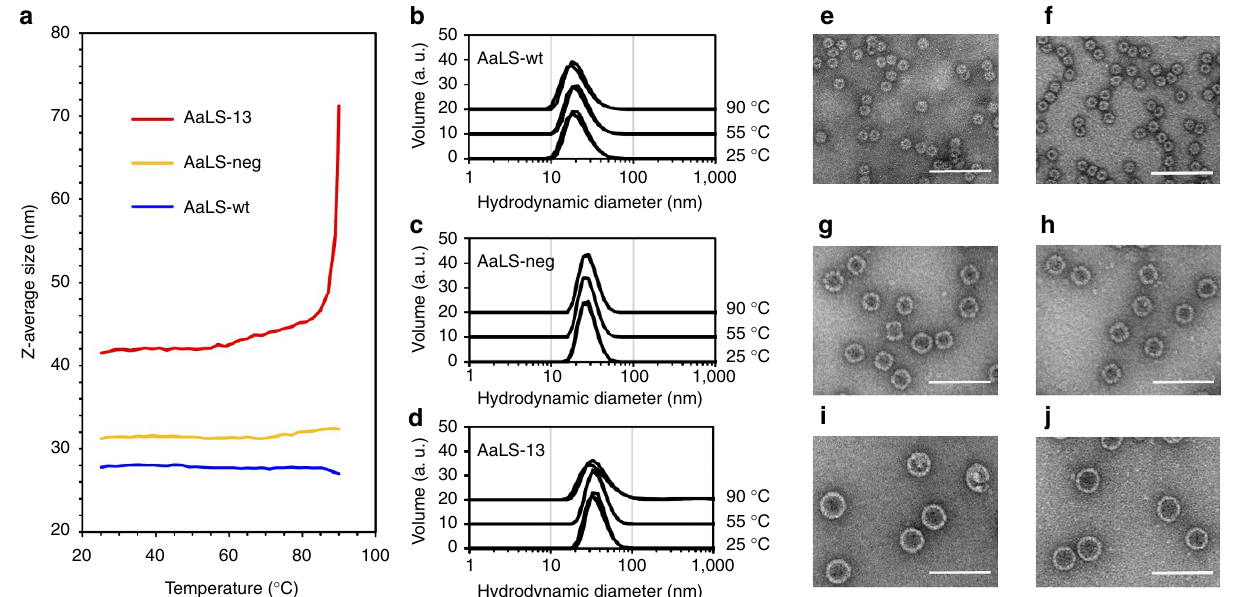
Figure 5 | Thermal stability of the AaLS variants. ( a ) DLS measurements with AaLS-wt (blue), AaLS-neg (ochre) and AaLS-13 (red). Z-Averages 68 of the particles are plotted against the measured temperature (25–90 (cid:2) C). The Z-averages of AaLS-neg ( B 32nm) and AaLS-13 ( B 42nm) correspond to the expected hydrodynamic diameters expected for 29- and 39-nm wide cages, respectively. However, the Z-average ( B 28nm) for AaLS-wt was significantly larger than the expected hydrodynamic diameter of a 16-nm wide cage, suggesting that a fraction of the particles aggregate in solution. ( b – d ) Volume weighted distribution of the hydrodynamic diameters determined for AaLS-wt ( b ), AaLS-neg ( c ) and AaLS-13 ( d ) at 25, 55 and 90 (cid:2) C. The individual histograms are offset by 10 arbitrary volume units (a.u.) for clarity. Three independent measurements were performed and plotted for each condition. ( e – j ) Negative-stain EM images of AaLS-wt ( e , f ), AaLS-neg ( g , h ) and AaLS-wt ( i , j ). Each sample was deposited on the EM grid without heating ( e , g , i ) or immediately after heating for 5min at 90 (cid:2) C ( f , h , j ). Scale bars, alignments of selected particles in 50 classes for AaLS-wt and AaLS-13 and 80 difference density and the resolution of the EM map does not allow modelling of a classes for AaLS-neg were performed by RELION 1.4. Particles that did not yield ligand at atomic detail de novo , we left this area of the map uninterpreted. high-resolution class-averages were excluded from further refinement For the AaLS-neg and AaLS-13 mutants, the affected residues were exchanged (Supplementary Figs 2–4 for more detailed workflows). Images of the selected 2D in one of the 1HQK protomers, which then was expanded to 15 (AaLS-neg) or 6 class-averages were used to reconstruct initial low-resolution models by imposing (AaLS-13) positions to generate the asymmetric unit (ASU) of the particles. Areas icosahedral symmetry for AaLS-wt and AaLS-13 or tetrahedral symmetry for of the ASU models located outside of the EM-density were manually readjusted in AaLS-neg with the program e2initialmodel.py in EMAN 2.1. 3D classification was each monomer, which included a stretch around helix a 4 (residues 117–134) and a then performed with RELION 1.4 using the low-pass filtered initial models to 50Å neighbouring loop (residues 82–90). A few residues were added to the C -terminal a 5 helix, which extends further towards the periphery of the particles. After as references. Further 3D classification and refinement were performed using full- sized images (1.39Å per pixel) and masks excluding the cage cavities. tetrahedral 12-fold (AaLS-neg) or icosahedral 60-fold (AaLS-13) symmetry expansion, the full model was refined using a similar strategy as outlined above for AaLS-wt, except for B-factor refinement, which was performed in a ‘two groups per Cryo-EM structural analysis . The cryo-EM maps and the molecular structures residue’ mode (Table 1). Because of the limited resolution in the B 5Å range, in were analysed using UCSF Chimera 1.11 (ref. 57) and PyMOL (Version 1.7, which only large bulky residues are visualized, the refined model was truncated to Schro¨dinger LLC). Local resolutions of the EM maps were estimated using the the backbone. ResMap program 58 . Electrostatic surface potentials were calculated for the crystal structure (PDB: 1HQK) 14 , for AaLS-wt, and mutation imposed crystal structure, for AaLS-neg and AaLS-13, at pH 8 and an ionic strength of 150mM using for the pH and ionic strength parameters. The graphics used for the figures and movies were generated using UCSF Chimera or PyMOL. Atomic model building and refinement . For generation of a coordinate model that includes the entire AaLS-wt particle, one protomer of the corresponding crystal structure (PDB: 1HQK) 14 was adjusted to the EM density using the program O (refs 62,63) and symmetry expanded using the icosahedral operators from RELION 1.4 (ref. 56). The resulting model was subjected to phase-restrained reciprocal space refinement in PHENIX (ref. 64) (Table 1) against amplitudes and